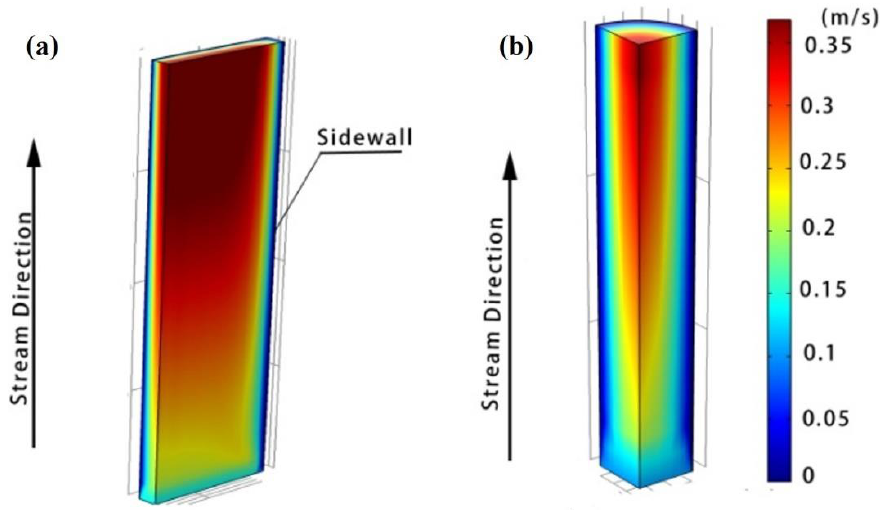
Figure 9. Velocity distribution in gas phase ( a ): box-type; ( b ): tube-type).